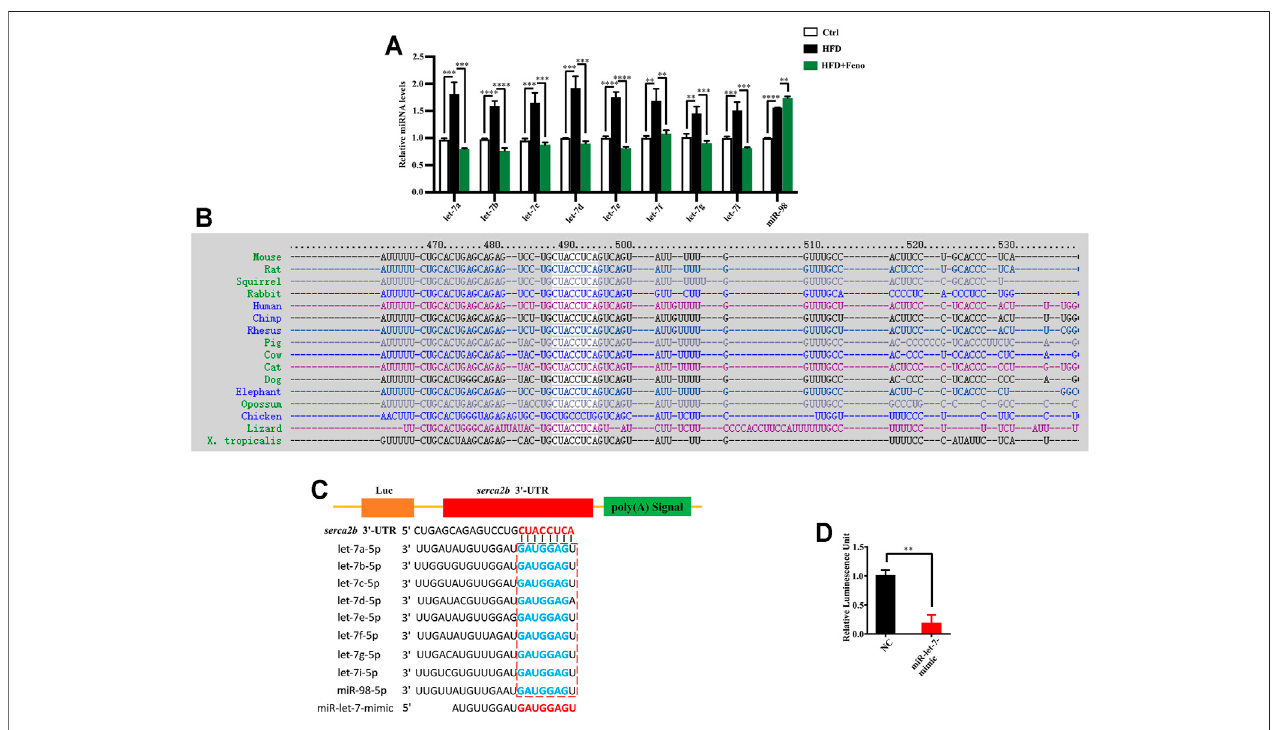
FIGURE5| Let-7regulatestheexpressionofSERCA2b. (A) qPCRanalysiscon fi rmedthatfeno fi brateattenuateslet-7expressioninHFD-fedmiceafter14weeks. Theseresultsaremeans ± SD( n (cid:1) 3 − 9mice/group).** p < 0.01,*** p < 0.001,**** p < 0.0001,HFDgroupversuscontrolgroup,orfeno fi brate+HFD-fedgroupversusHFD group. (B) Sequences of the SERCA2b in different species. SERCA2b is highly conserved in different species. (C) Complementarity between the 3 ′ UTR of SERCA2b mRNA and let-7. The box indicates the seedregionofthe let-7family. (D) Luciferaseanalysis ofareporter vector harboring the 3 ′ UTRof SERCA2b in HepG2 cells transfectedwithanegativecontrol(NC)mimicormiR-let-7mimictogetherwithpsiCHECK2- SERCA2b 3 ′ UTRreporterplasmidsfor48 h.Theseresultsaremeans ± SD of three independent experiments. ** p < 0.01, miR-let-7 mimic group versus negative control